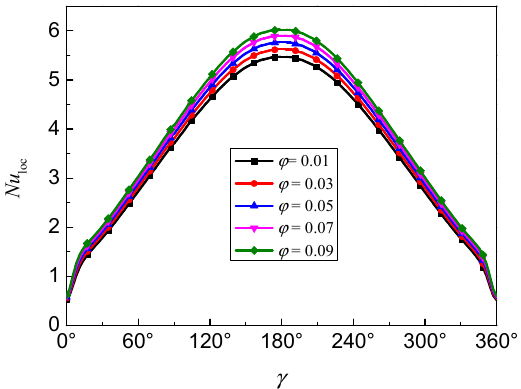
Figure 7. Average Nusselt number ( Nu avg ) of the inner wall for different nanoparticle volume fractions ( φ ) and Darcy numbers ( Da ) at Ra = 10 5 , d sp = 50 nm, ε = 0.5, and RR = 2.